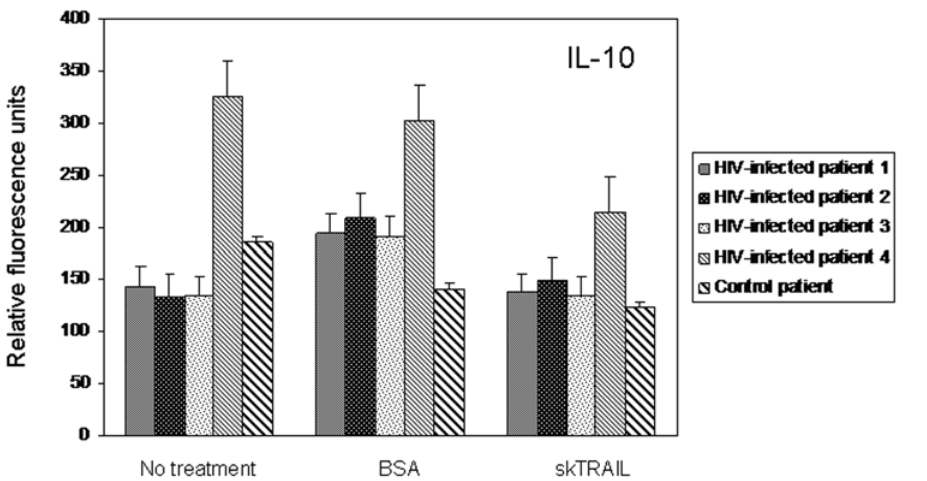
Figure 3. IL-10 expression following treatment of HIV-infected PBLs with skTRAIL, a representative example of results obtained from assays with the Bio-Plex human cytokine 27-plex panel. PBLs were collected from 4 HIV-infected donors and 1 uninfected control. Cells received either no treatment or were treated with either BSA (5 ng/ml) or skTRAIL (5 ng/ml). Following 24 h of culture, supernatants were collected for measurement of cytokine expression. Values are presented as relative fluorescence units, reflecting a range of concentrations from 0.08 to 2.01 pg/ml based on extrapolation from a standard curve generated with known concentrations of IL-10 at the time of analysis.